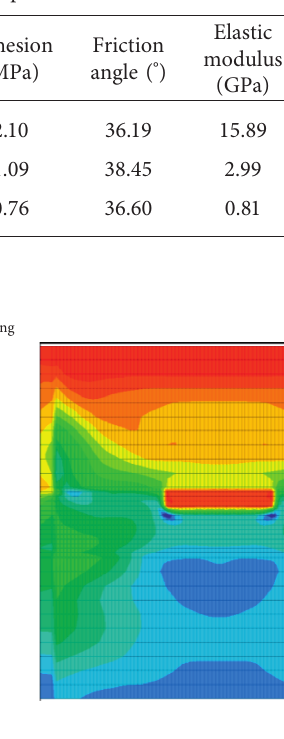
Figure 6: The numerical model of the mining area Section #1000. Table 1: Mechanical parameters of the model.